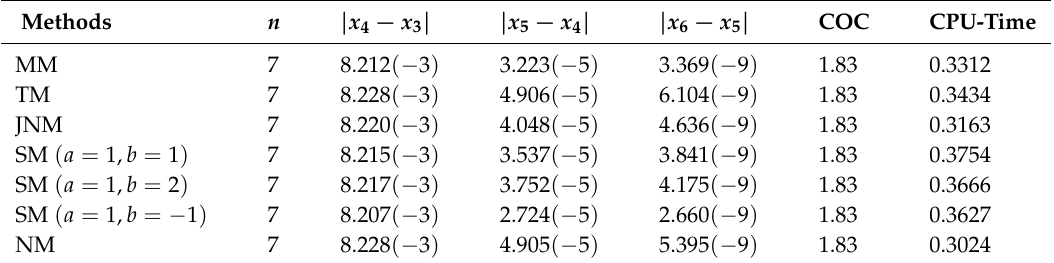
Table 2. Comparison of performance of methods for function f 2 ( x ) , taking x 0 = 1.1, x 1 = 2.3, x 2 =